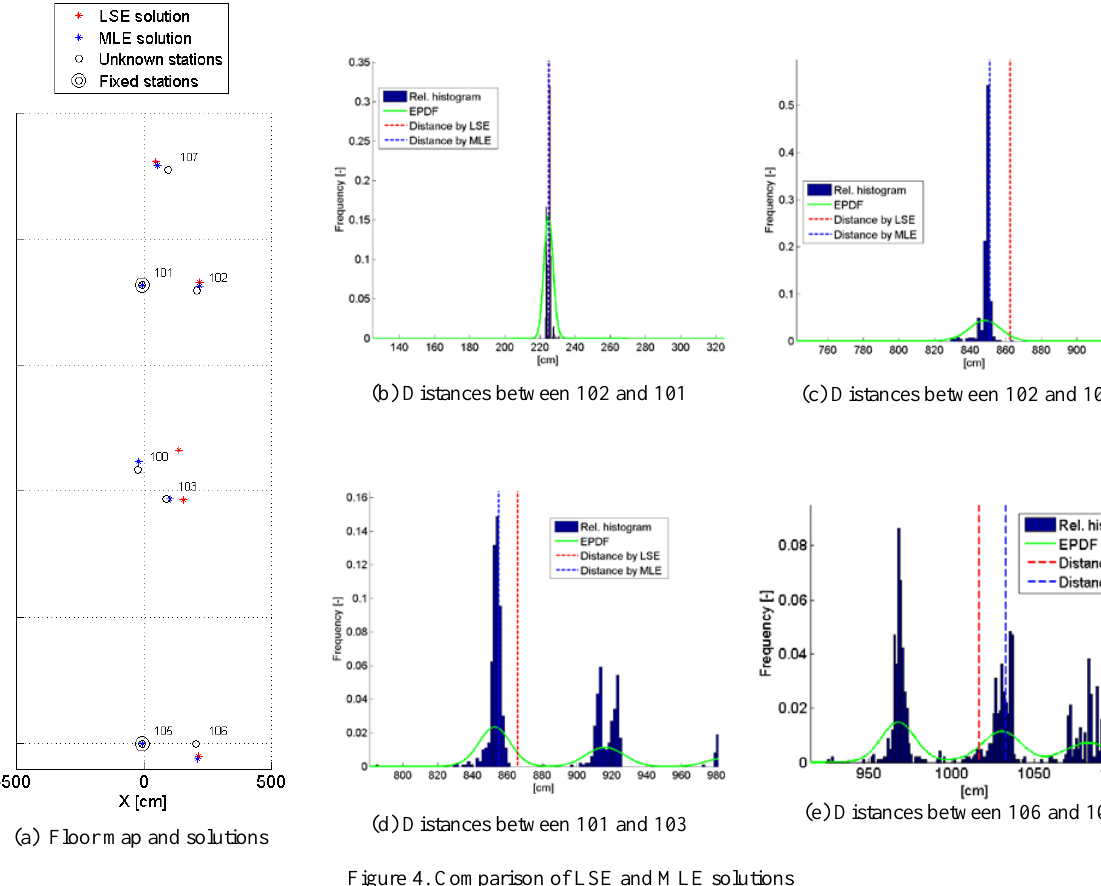
Figure 4. Comparison of LSE and MLE solutions